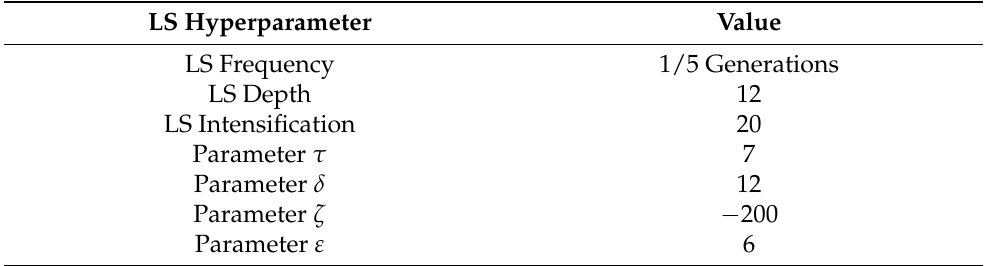
Table 3. LS Hyperparameters used for the MA